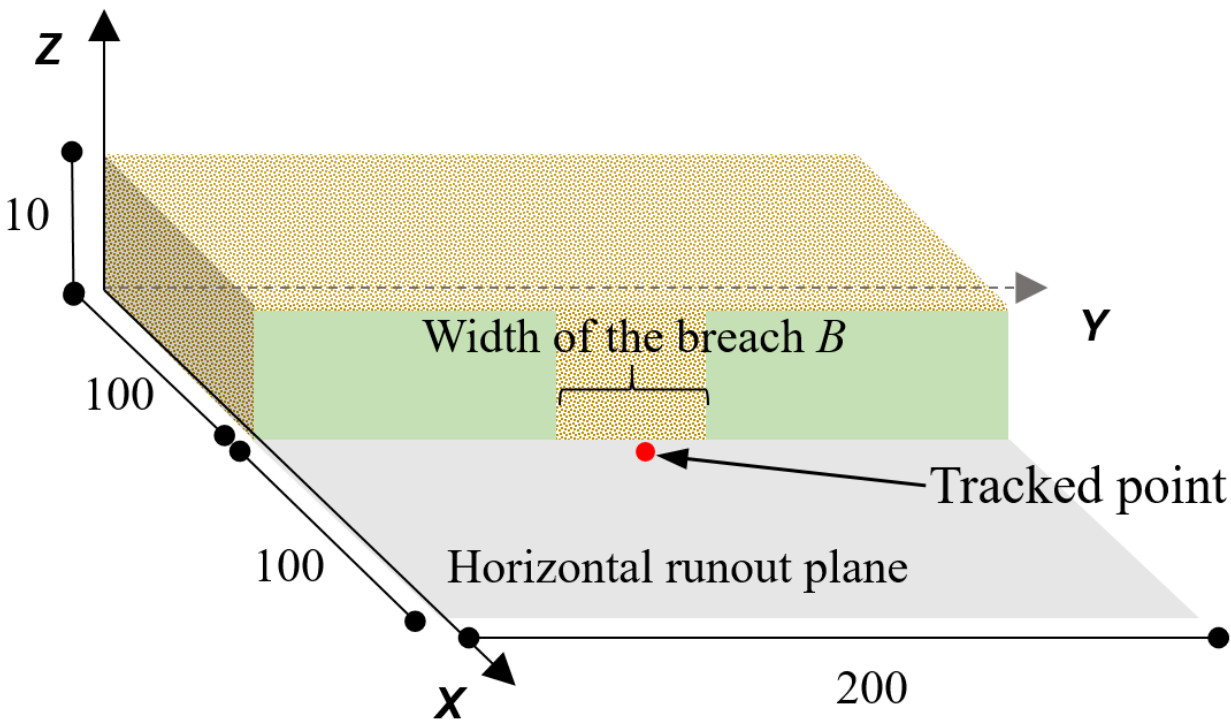
Figure 7. Schematic of the box-shaped pile of granular mass before collapse through a rectangular breach into a horizontal runout plane (unit: m).